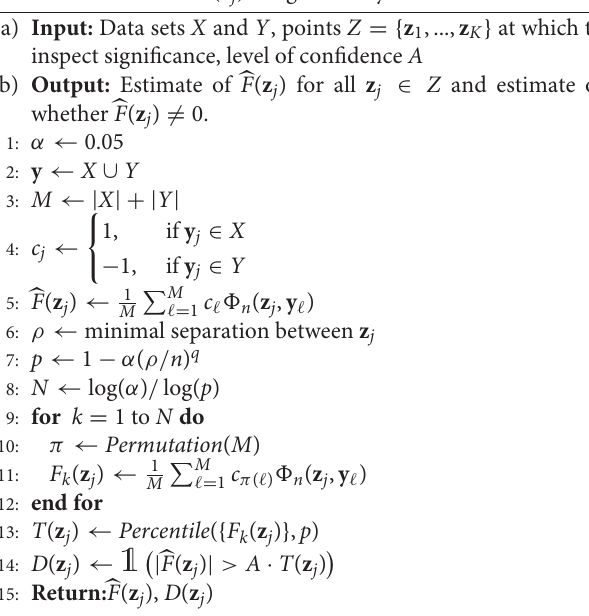
Algorithm 1 for the two class test, and Algorithm 2 for the